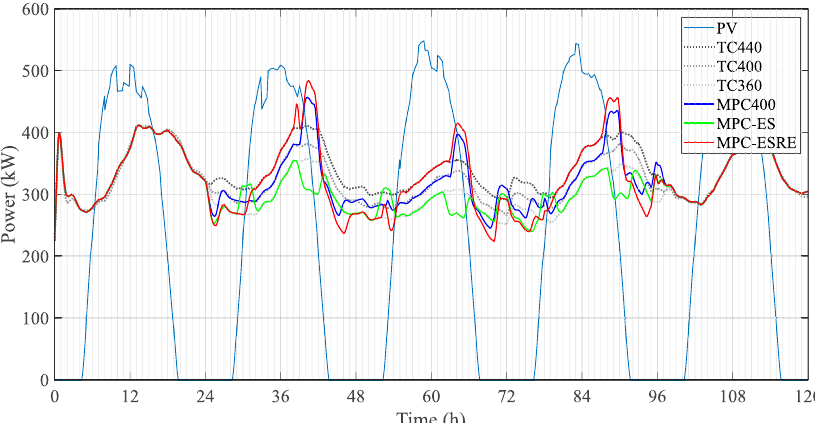
Figure 9. Compression and PV power of the multi-objective case study with the traditional control strategies and the different MPC scenarios.